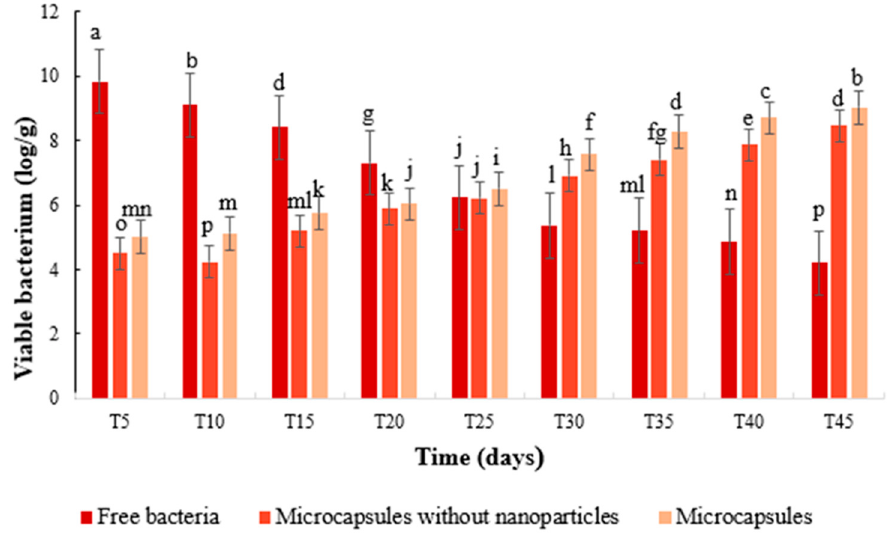
Figure 8. Changes in the viable amount of S. fulvissimus Uts22 colonizing on the cucumber root by free bacteria, microcapsules without nanoparticles and microcapsules treatments. (X-axis is 5th to 45th days after the start of bacterial release from the capsule and the Y-axis is logarithm of the viable bacteria has been released). Different letters indicate significant differences among treatments.